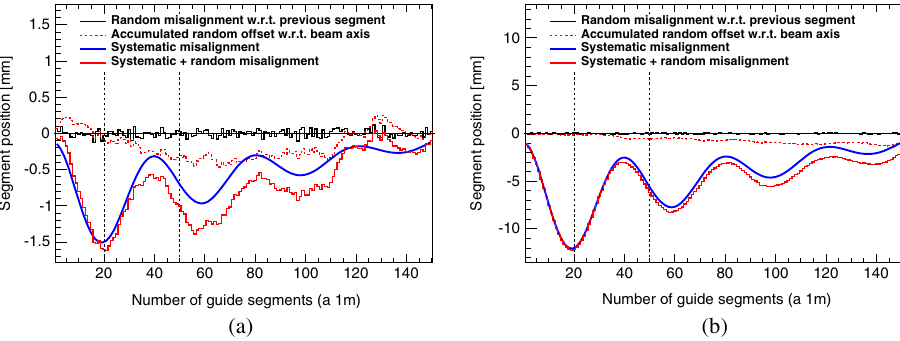
FIG. 1. Position of the beam line segments as a function of the number of guide segments, two examples of the combination of systematic and random neutron guide misalignment: the black line shows a random misalignment of 50 μ m with respect to the previous guide segment, the dotted red line the accumulated random misalignment with respect to the nominal guide axis. The blue line shows the systematic misalignment which is added to the random component to give the total misalignment with respect to the nominal guide axis, shown as solid red line. Guide segments are 1 m long. Note the different y axis scale to compare these examples. 1.5 mm (a) and 12 mm (b) maximal systematic